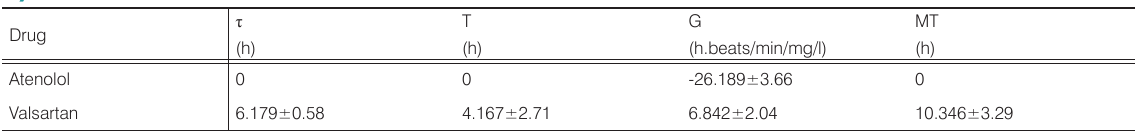
Table 3. The estimated model parameters of PK/PD system for HR after atenolol and valsartan administration separately (a) and in combination (b).